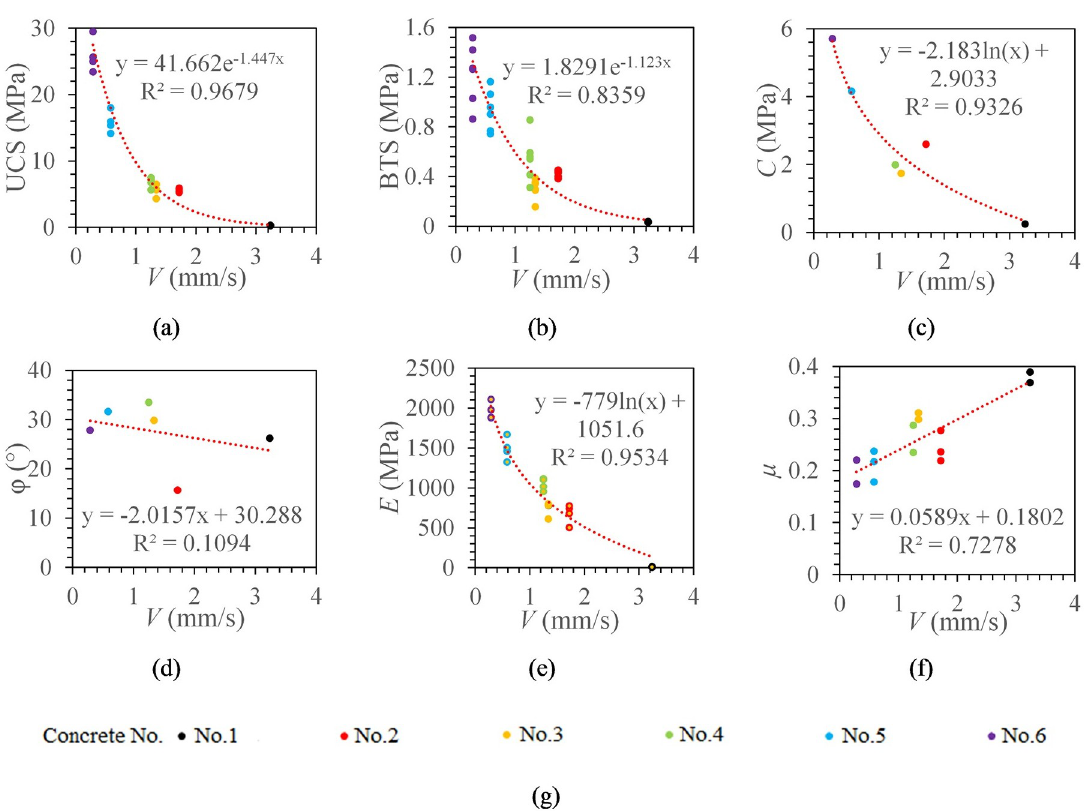
Fig 5. The relationship between the stabilized ROP and the concrete mechanical parameters. (a) The relationship between V and UCS. (b) The relationship between V and BTS. (c) The relationship between V and C . (d) The relationship between V and φ . (e) The relationship between V and E . (f) The relationship between V and μ . (g)